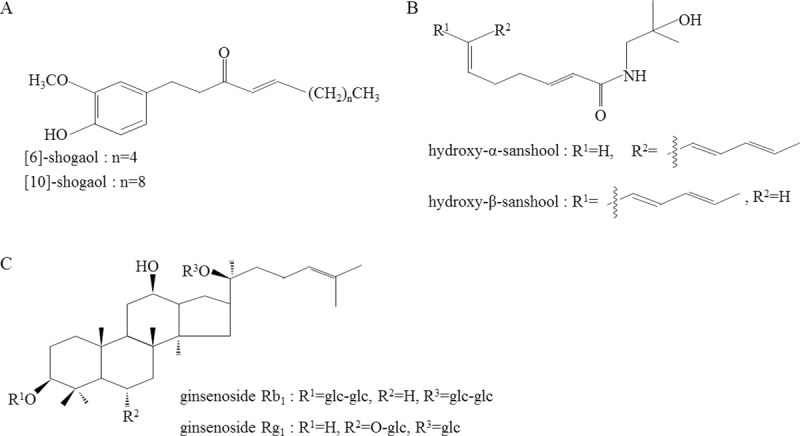
Structural formula of major components in TJ-100.(A) shogaol. (B) hydroxy-sanshool. (C) ginsenoside.